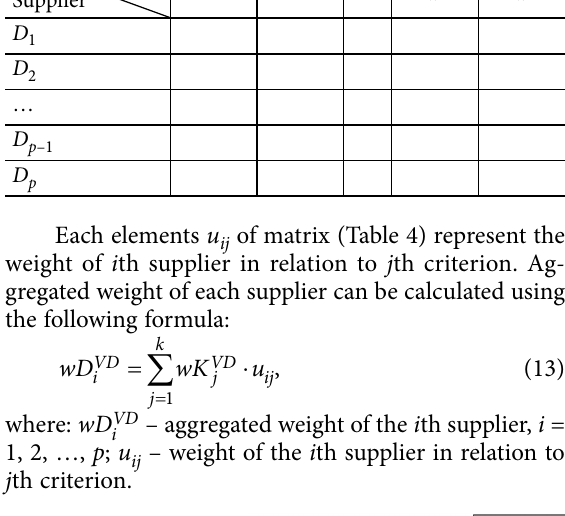
Table 2. Matrix of weights for each p suppliers due to each k criteria Criterion